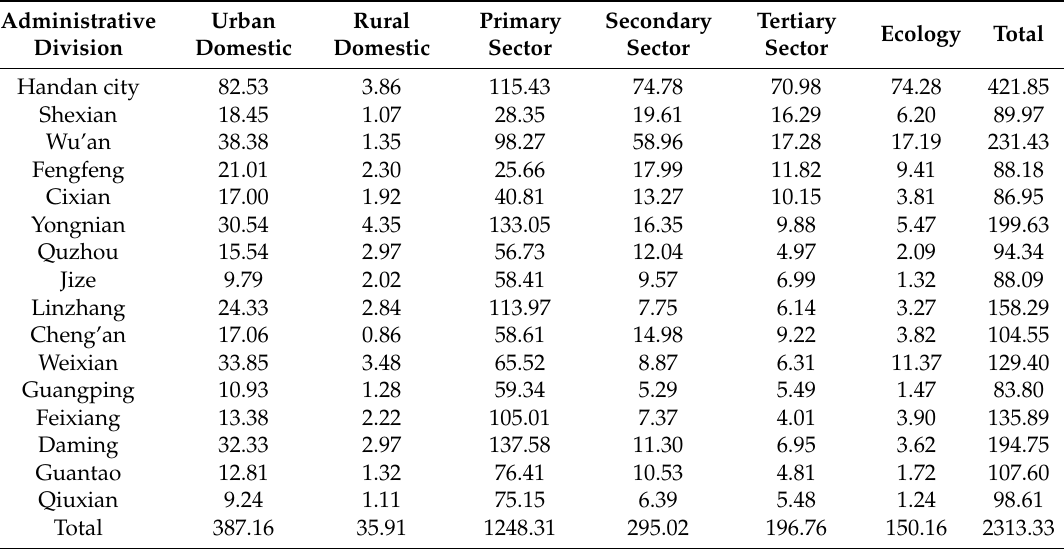
Table 16. Results for water allocation of PSO (10 6 m 3